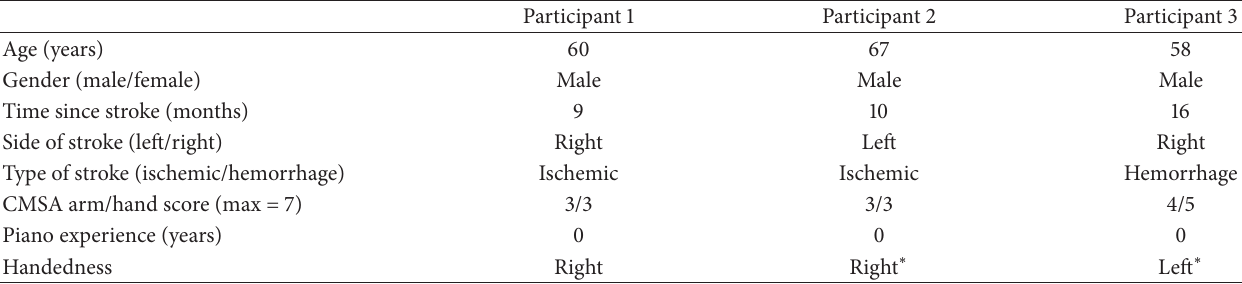
Table 1: Initial participant